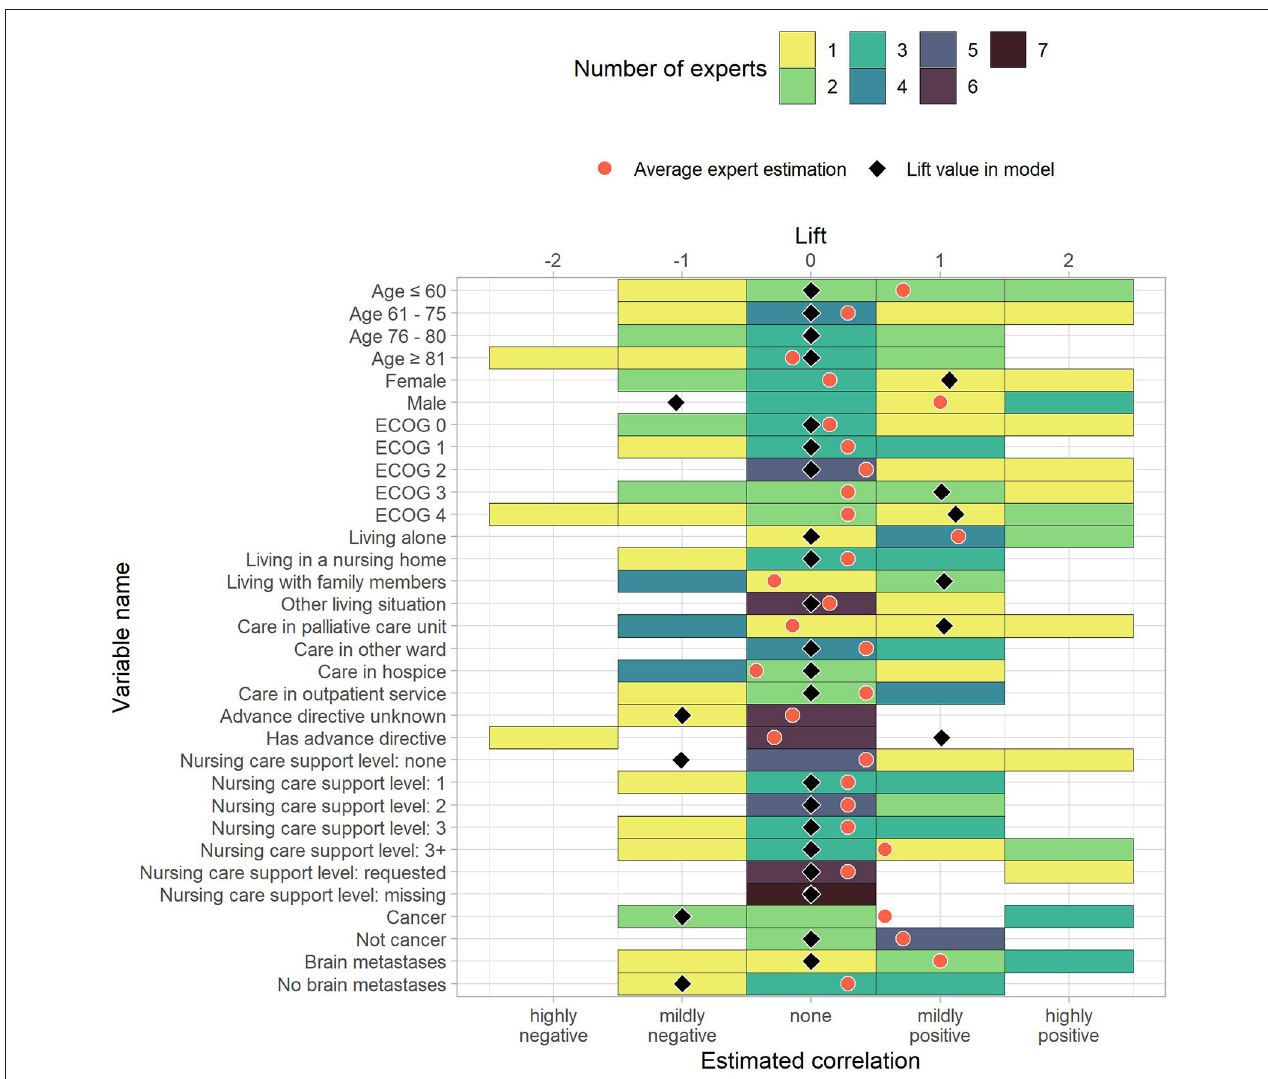
FIGURE 3 | The estimated correlations of HOPE variables to anxiety for demographic and administrative data as well as diagnoses. The color indicates how many experts chose the corresponding option. The black diamond indicate the lift value of the corresponding variable in the model, where 0 stands for “not part of the model” and negative values correspond to the lift of no-rules. The red dot is the average expert